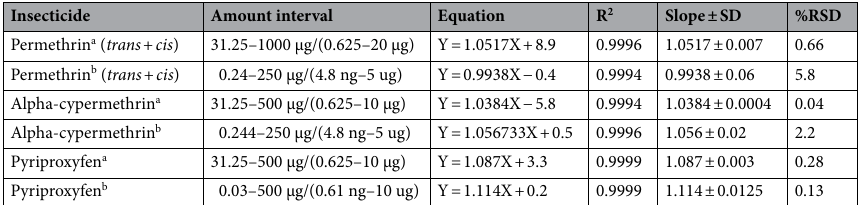
Table 2. Linearity parameters, regression equations, correlation coefficients (R 2 ), and standard deviations (SD) found during linearity, LoQ, and LoD testing*. *Chromatographic conditions used: 70% acetonitrile: 30% water isocratic mobile phase, 1/min flow rate, 40-min run time and an analysis wavelength of 226 nm. The column used for analysis was a Hypersil GOLD C18 column (75 Å, 250 × 4.6 mm, 5-μm particle size; Thermo Scientific). a Data obtained from linearity validation where b data obtained from LoQ and LoD calculation. A triplicate set of standards were prepared for each insecticide. SD; standard deviation and % RSD; relative standard deviation (SD/Mean*100).